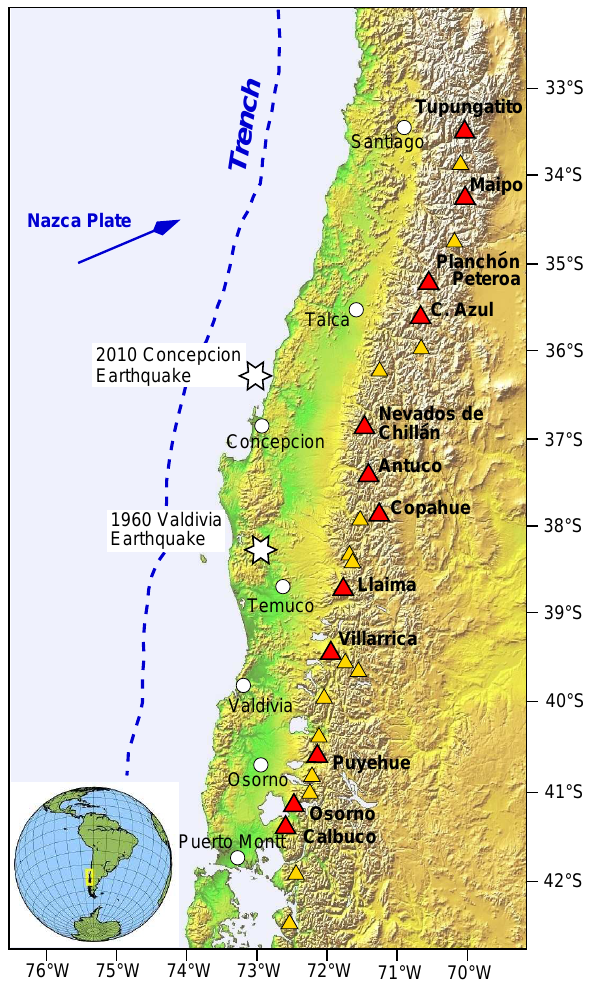
Fig. 1. SRTM image of the Chilean Southern Volcanic Zone (SVZ) displaying the location of the volcanoes considered in this study (red triangles), other major volcanic centres within the SVZ (yel- low triangles), epicentres of the earthquakes (white stars), the plate boundary (dashed blue line), major cities (white circles). Inset shows the location of the SVZ on the South American continent. Image courtesy SRTM Team NASA/JPL/NIMA,